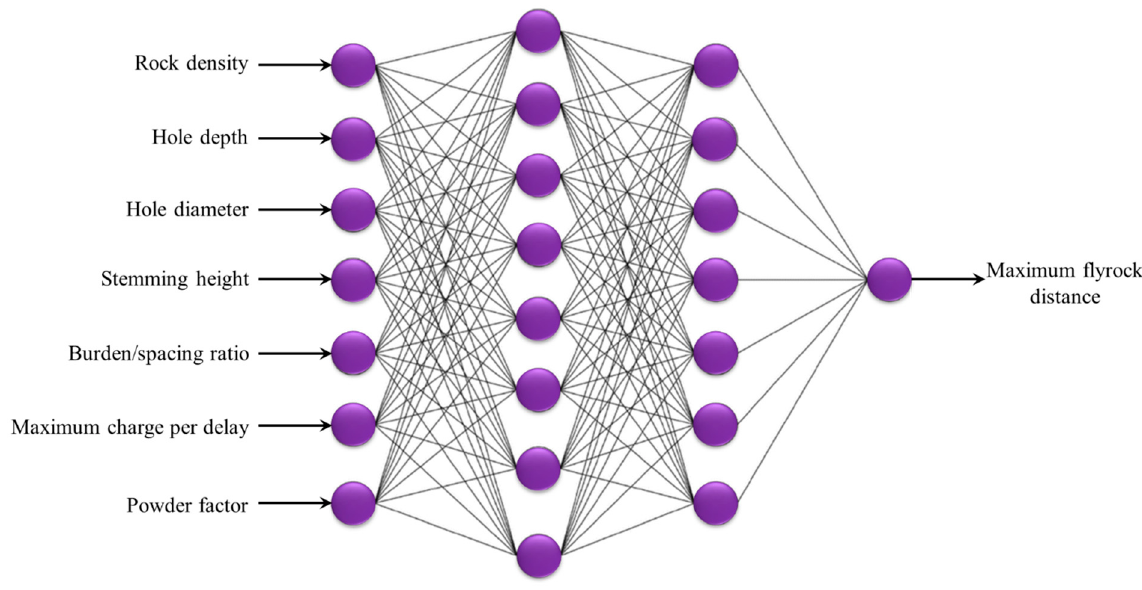
Figure 8. General structure of an ANN model to forecast the maximum flyrock distance.